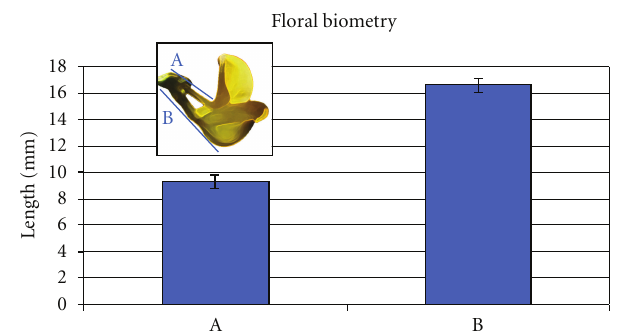
Figure 2: Floral biometry of C. emerus . Data show measurements as in the figure. Bars indicate standard